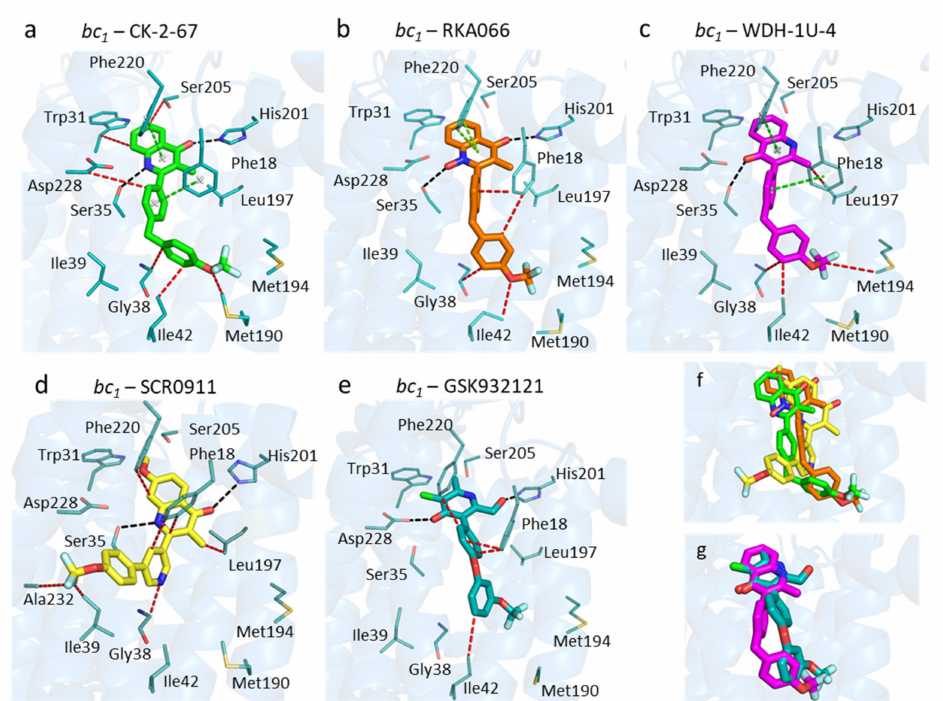
Figure 3. Binding modes of selected antimalarial compounds within the bovine Q i site. ( a ) CK-2-67 (green sticks). ( b ) RKA066 (orange sticks). ( c ) WDH-1U-4 (magenta sticks). ( d ) SCR0911 (yellow sticks) from the 5OKD structure. ( e ) GSK932121 (teal sticks) from the 4D6U structure. ( f ) Superimposed crystal structures with 2-aryl 4(1H)-quinolones: SCR0911, CK-2-67, and RKA066. ( g ) Superimposed crystal structures of WDH-1U-4 and GSK932121. Black, cyan, green, and red dashes represent hydrogen bonds, electrostatic, aromatic-aromatic, and hydrophobic interactions between ligands and protein residues, respectively. The blue cartoon represents the bovine cytochrome b